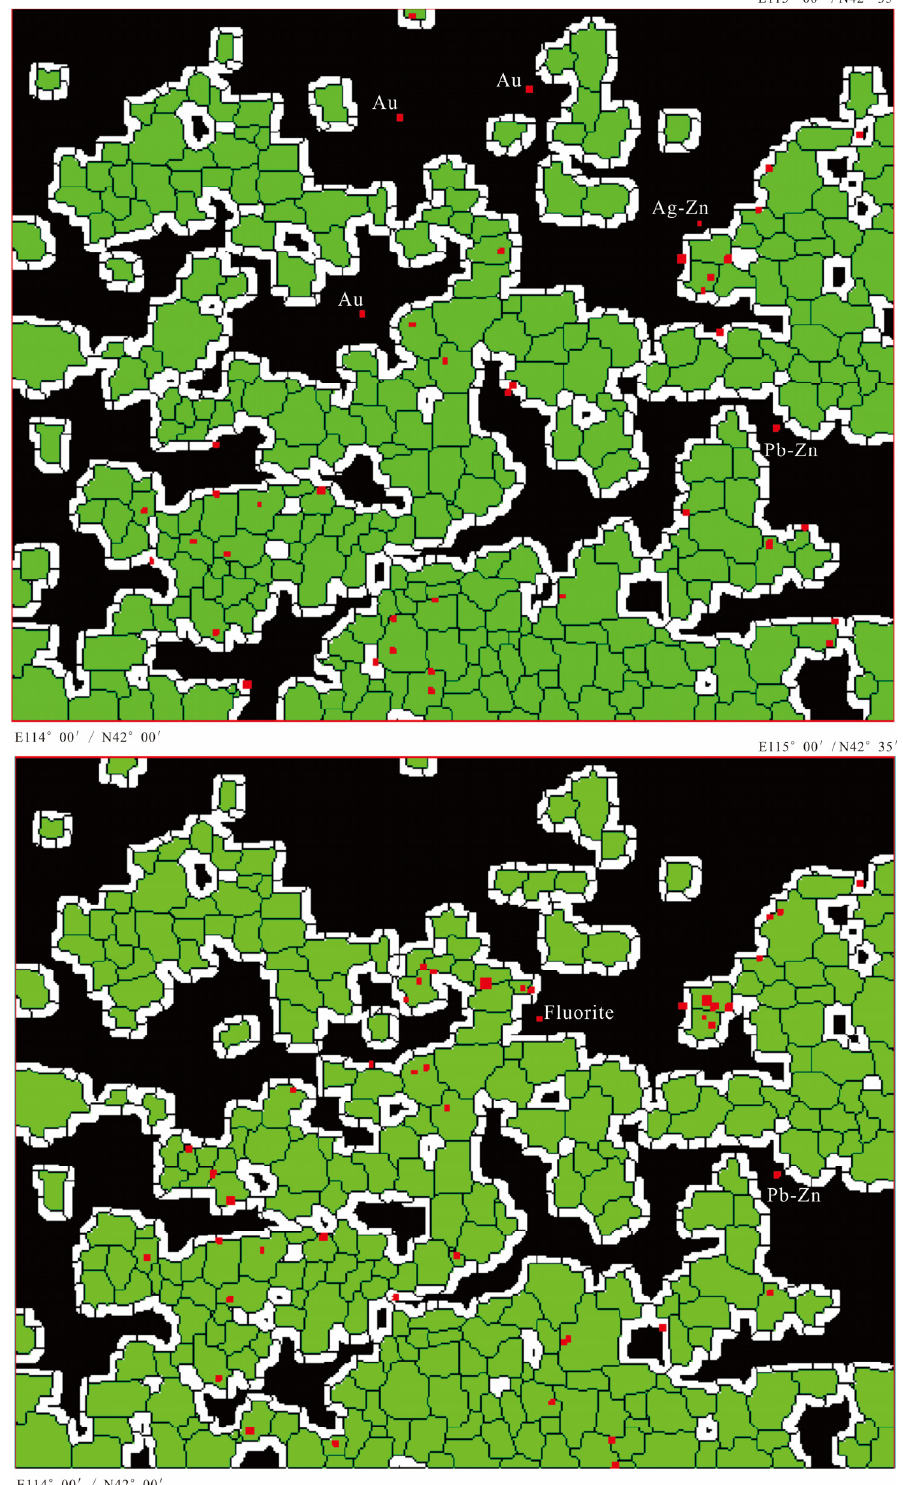
Figure 13. (upper) the buffered anomalous regions (green colored patches edged with white, delin- eated by the 50% quantile) for I-series elements with relevant ore spots overlaid on it. (lower) the buffered anomalous regions for S-series elements with relevant ore spots overlaid on it. The ore spots not falling in the anomalous regions are labelled with their mineral species. Other legends in this figure are consistent with those in Figures 9 and 10.